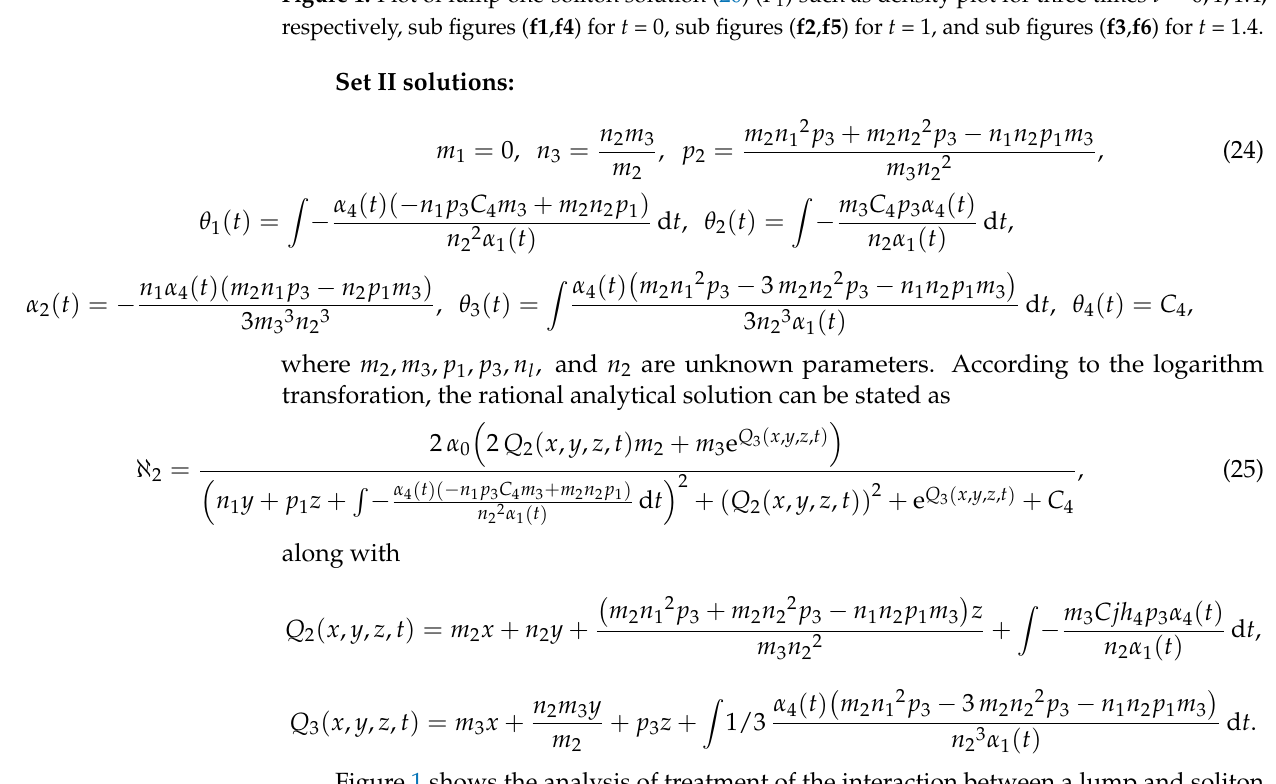
Figure 1. Plot of lump one-soliton solution (20) ( Γ 1 ) such as density plot for three times t =